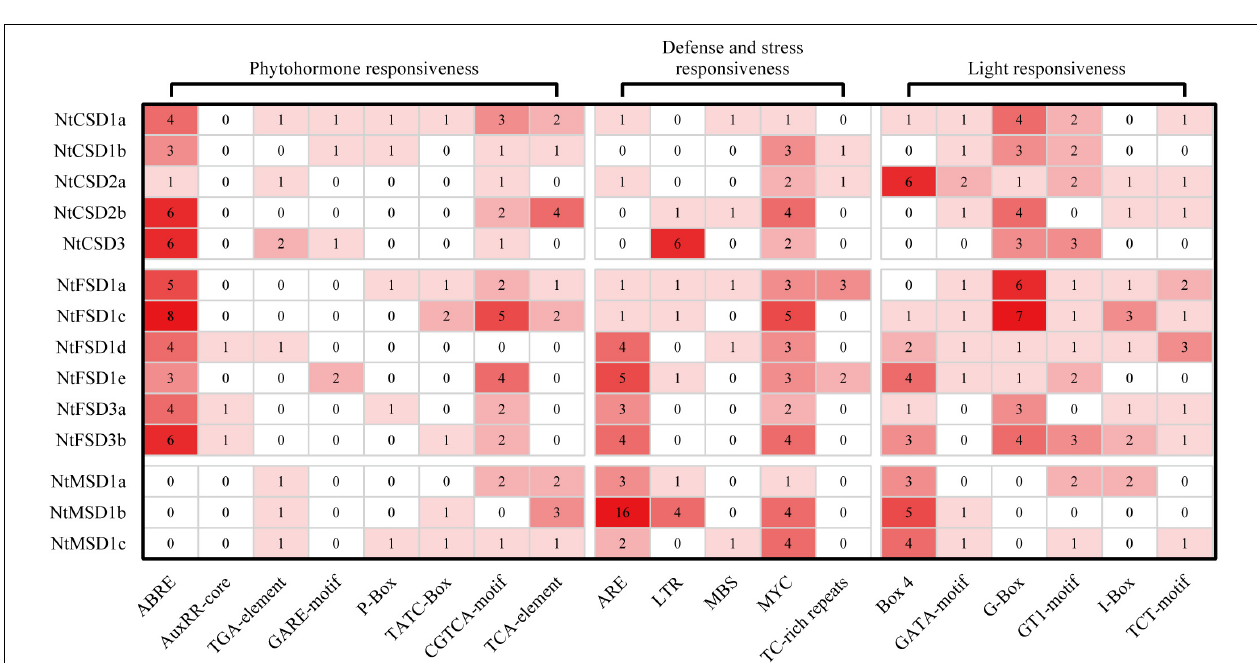
FIGURE 3 | Phylogenetic tree, conserved motifs of NtSOD proteins, and exon-intron structures of NtSOD genes. (A) A neighbor-joining tree of NtSOD proteins. (B) Seven motifs in NtSOD proteins identified using the MEME tool are marked by different colors. (C) Exon-intron structures of NtSOD genes. Introns, UTRs, and CDSs are displayed with gray lines, gray boxes, and green boxes, respectively.